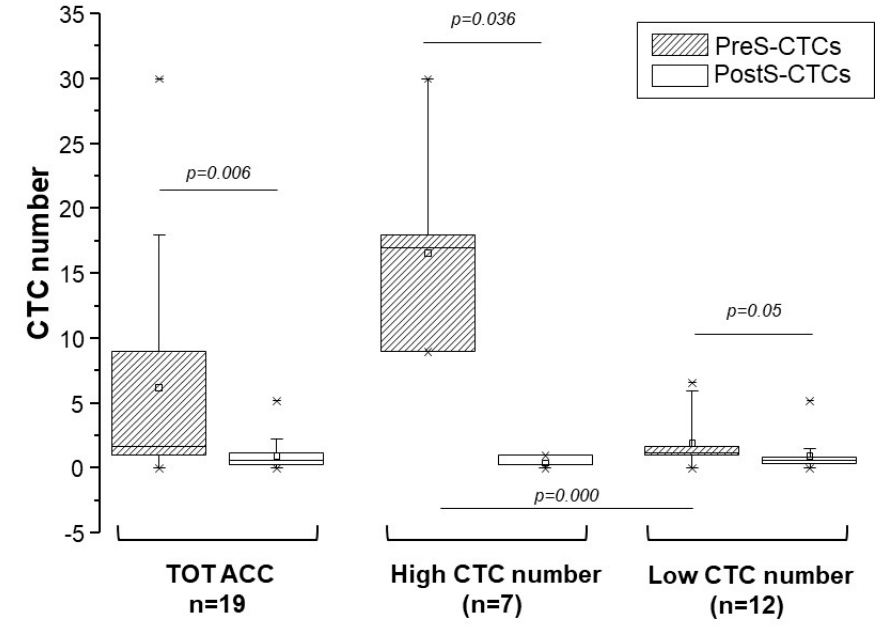
Figure 2. CTC distribution in pre ‐ surgery and post ‐ surgery blood samples in ACC patients. Box charts indicate CTC number distribution between pre ‐ surgery (PreS ‐ CTCs) and post ‐ surgery (PostS ‐ CTCs) blood samples in the entire cohort of ACC patients (TOT ACC), and when the cohort was stratified in low and high CTC number in PreS blood samples classes according to the cut off of 9 CTCs (75 th percentile of the non ‐ parametric distributions of PreS CTCs). For each patient, when multiple samples were available, the median number of CTC was used for the analysis; * the lowest and the highest values for each group are indicated. As paired PreS and PostS samples were not available for all patients, differences between the two groups of data were analyzed by the Mann–Whitney U test for independent non ‐ parametric data, the resulting p values are indicated.